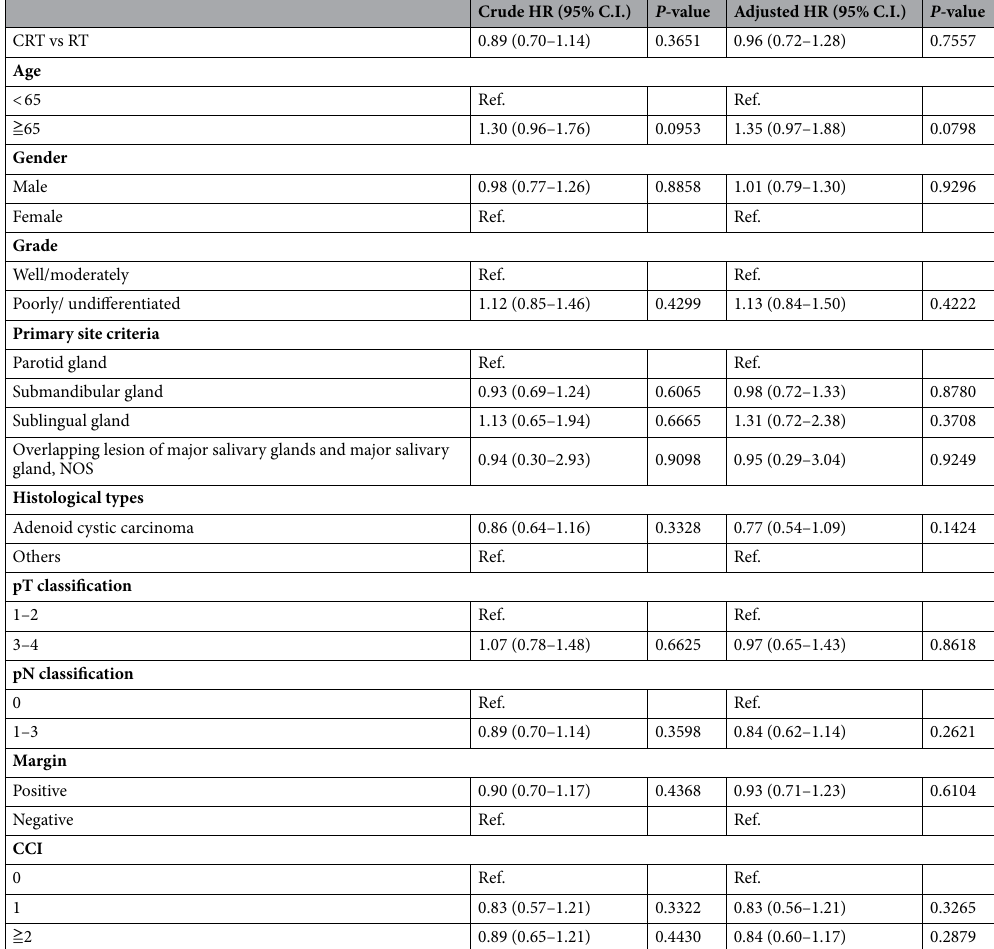
Table 3. Risk factor of disease-free survival in advanced major salivary gland cancer patients, n = 395. RT radiotherapy, CRT chemoradiotherapy, CCI Charlson Comorbidity